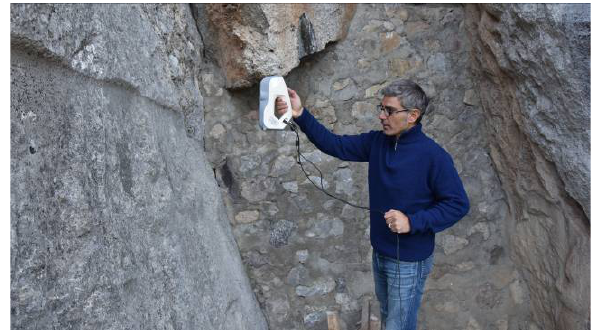
Figure 3. Acquisition procedures with the Artec Eva